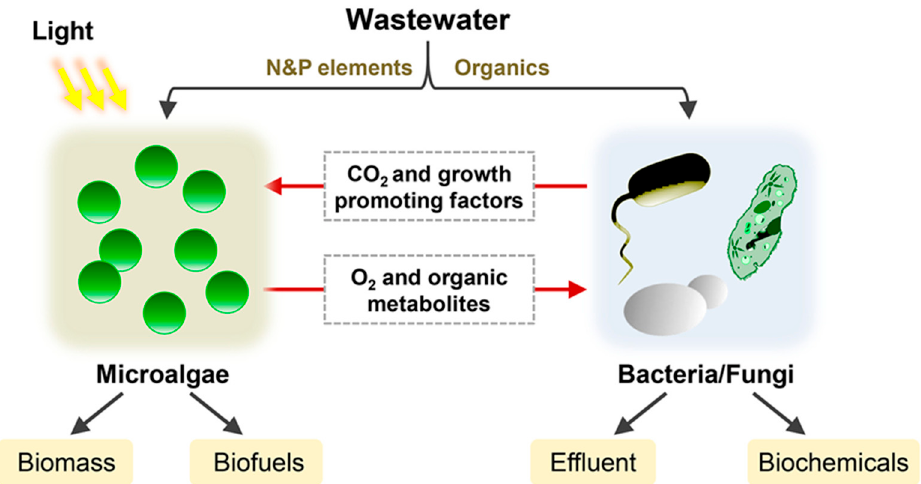
Figure 4. The synergistic interaction of microalgae and other microbes (such as bacteria) for wastewaters treatments. The consortium cells by metabolite exchange (organic compounds, O 2 , CO 2 and growth-promoting factors) play important role in the secondary and tertiary treatment of these waters; moreover, the harvested biomass can further be used as feedstock for biofuel or biochemical production. Reprinted with permission from Qian et al. (2020). Biotechnological potential and applications of microbial consortia. Biotechnology advances [32]. Copyright (2020) Elsevier.